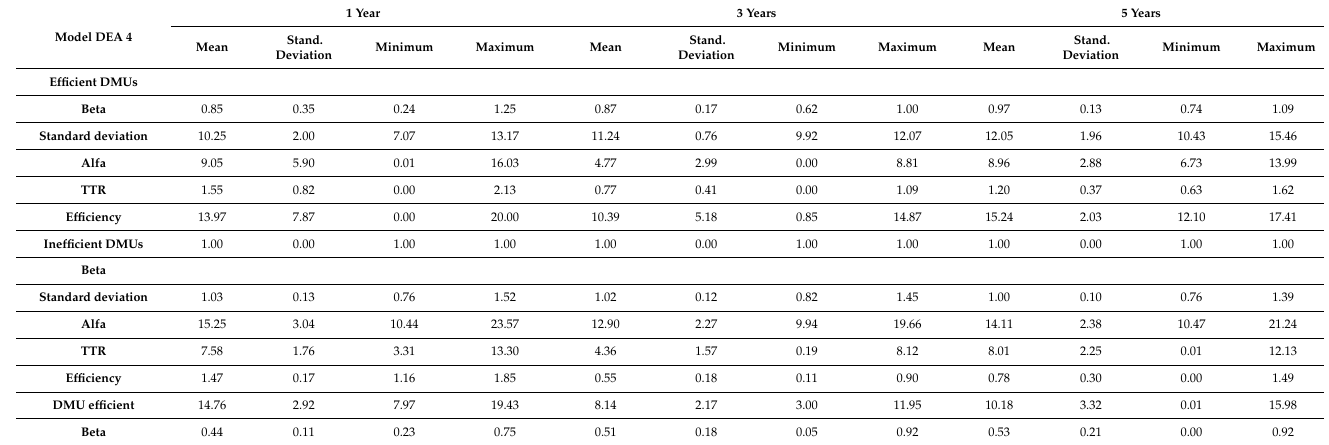
Table A12. Descriptive statistics of efficient and inefficient DMUs in model M4.